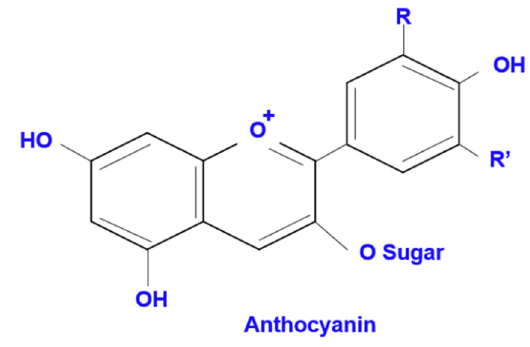
Figure 2. Illustration of anthocyanin molecule.